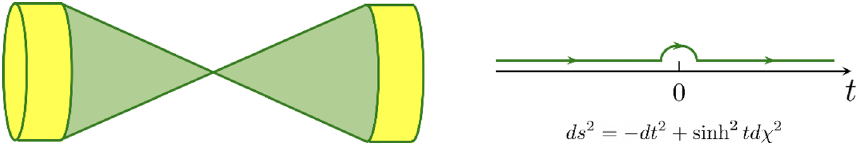
Figure 23 . The geometry that appear in the π contour is very similar to the double cone considered in [31], except for an overall sign in the metric, which exchanges space and time and changes the sign of the curvature, taking the locally AdS 2 space to a locally dS 2 one